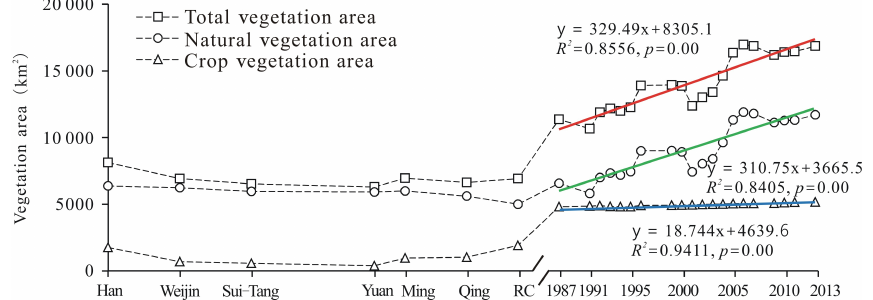
Figure 4. Temporal variations in total vegetation areas (square), natural vegetation (circle) and crops (triangle). It should be noted that data after 1987 reflect the results after applying a 3-year moving average to reduce the annual fluctuations.